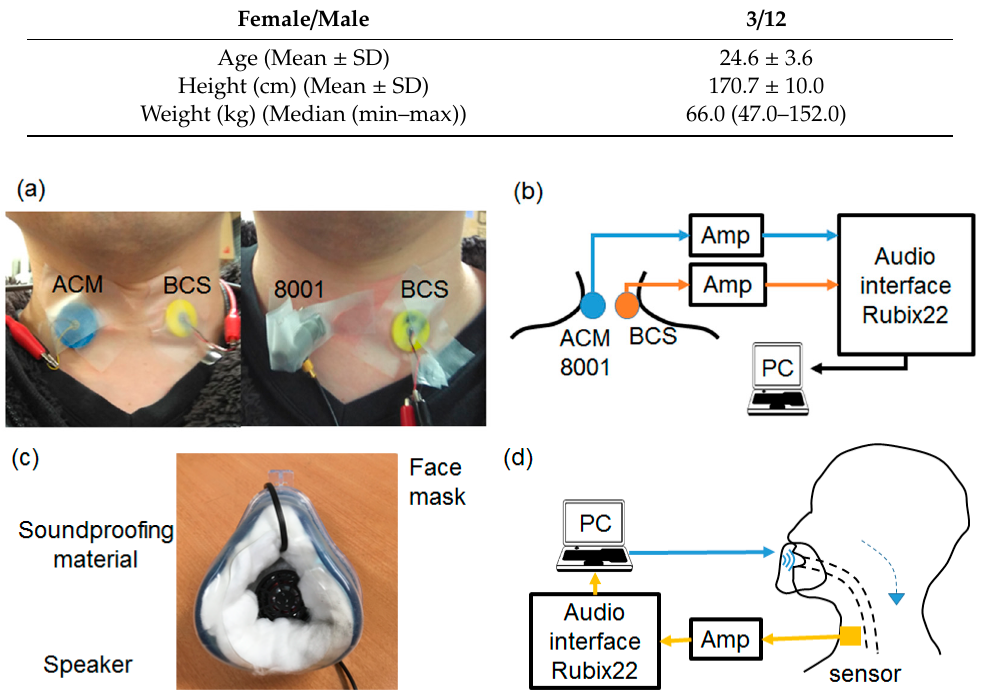
Table 3. Parameters for test subjects.